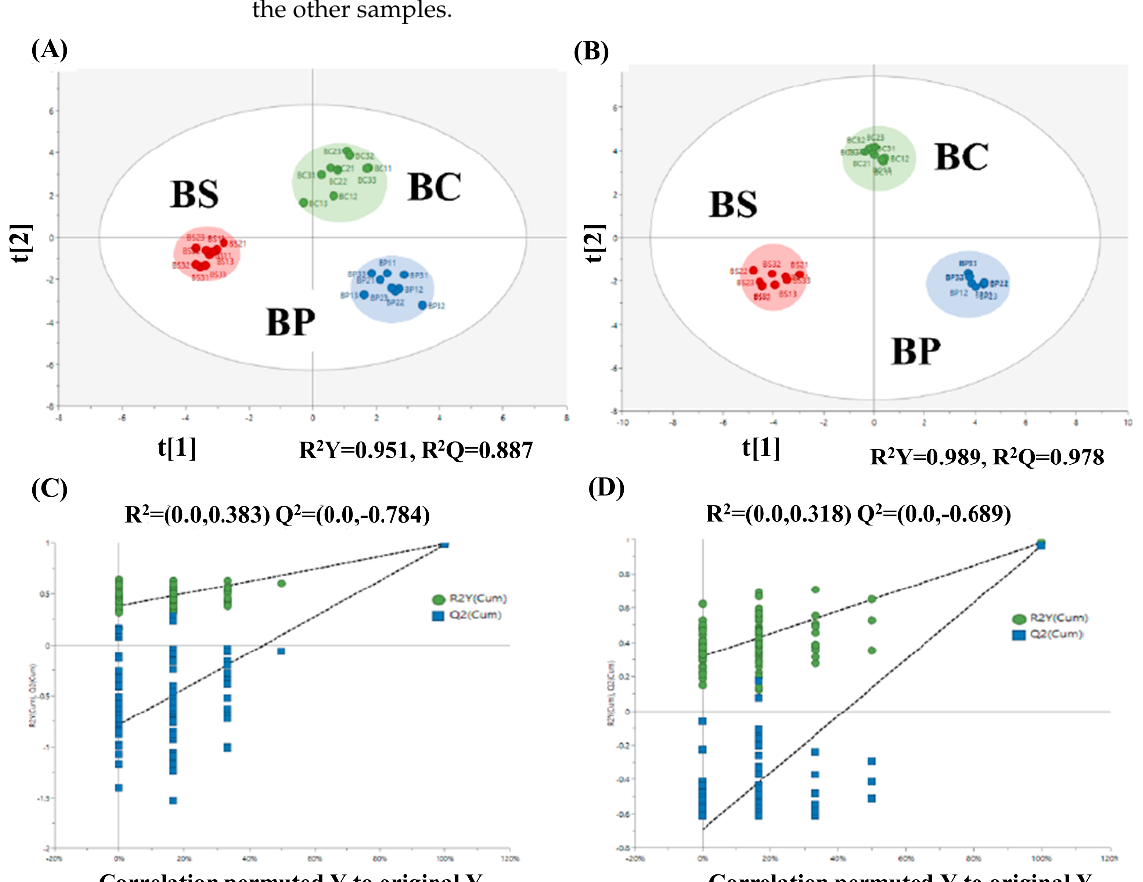
Figure 1. OPLS-DA score scatter plot of control (BC), alkaline pH (BP), and high salt concentration (BS) groups based on primary metabolite profiles ( A ) and secondary volatile metabolite profiles ( B ) obtained according to culture times. Permutation test plots based on primary metabolites ( C ) and secondary volatile metabolites ( D ) were conducted. Colors represent the following: red-BS, blue-BP, and green-BC. The meaning of the letters and numbers inside the score plot are the following: BC11-13, 21-23, and 31-33 (control samples obtained at phases I , II , and III in replication, respectively), BP11-13, 21-23, and 31-33 (BP samples obtained at phases I , II , and III in replication, respectively), and BS11-13, 21-23, and 31-33 (BS samples obtained at phases I , II , and III in replication, respectively).